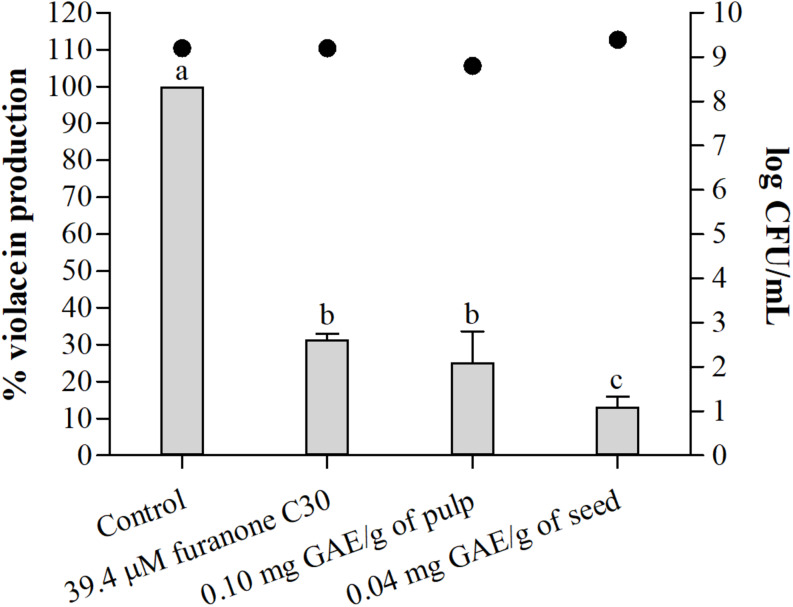
Percentage (%) of violacein production by C. violaceum ATCC 12472 in absence and presence of furanone C30, sub-MIC of pulp, and seed phenolic extracts of S. cumini (L.) Skeels. Bars represent % violacein production and points represent bacterial population in log CFU/mL. Means followed by different letters differ statistically (p < 0.05).